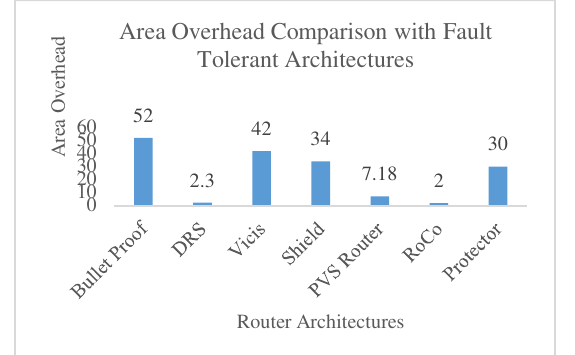
Fig. 14: Comparison of Area Overhead